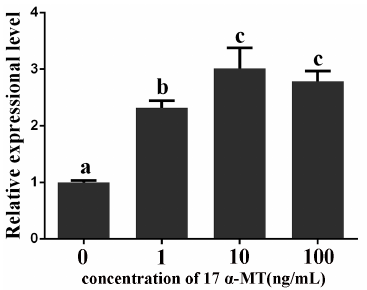
Figure 10. Expression of GATA6 mRNA in P. olivaceus testis cells stimulated with 1, 10 and 100 ng/mL 17 α -MT. qRT-PCR analysis was used to quantify GATA6 mRNA with β -actin as a reference. The relative expression variance is presented as a ratio (amount of GATA6 mRNA normalized to the values of the corresponding reference genes). The data are shown as the mean ± SD ( n = 3). Columns with different letters show a significant difference ( p < 0.05).